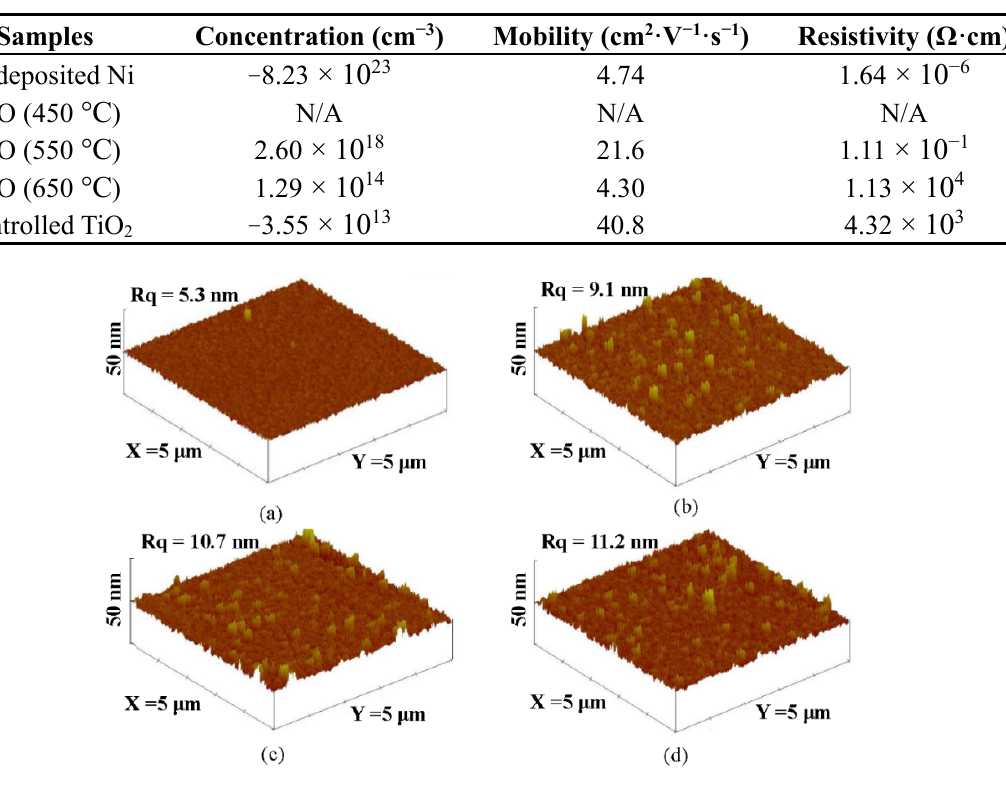
Figure 2. Surface roughness of the ( a ) controlled TiO 2 film; and the NiO/TiO 2 nanocomposite structures with an additive RTA process at temperature of ( b ) 450 °C; ( c ) 550 °C; ( d ) 650 °C, respectively.